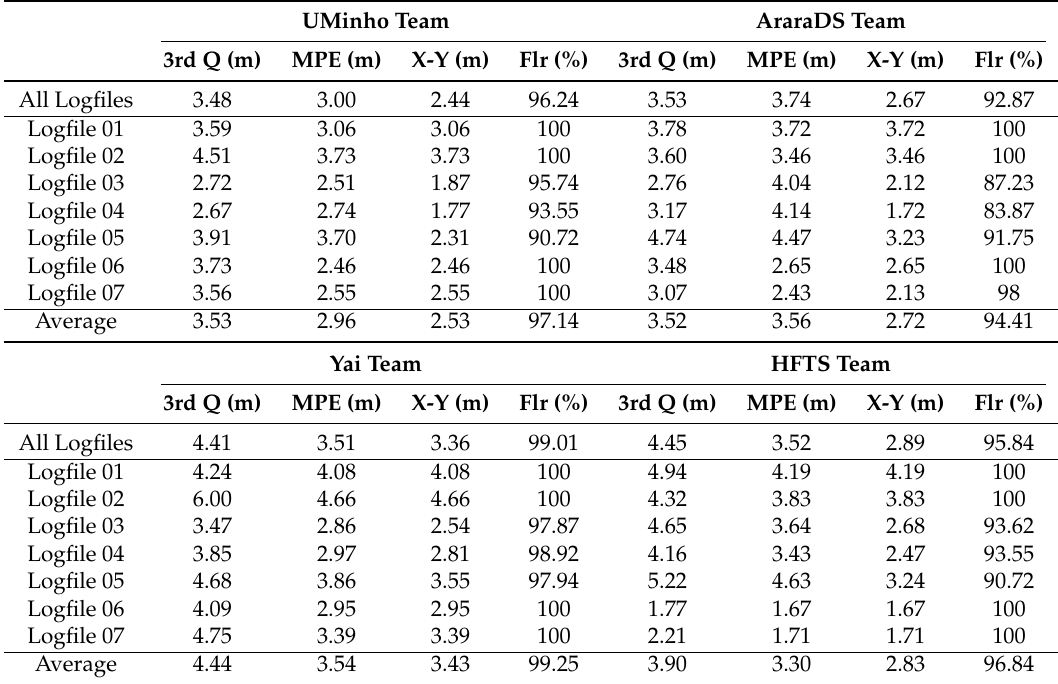
Table 4. Extended Competition Results—3rd quartile (3rd Q), Mean Positioning error (MPE), Two-dimensional error (X-Y) and Floor detection rate (Flr) on each logfile and aggregated